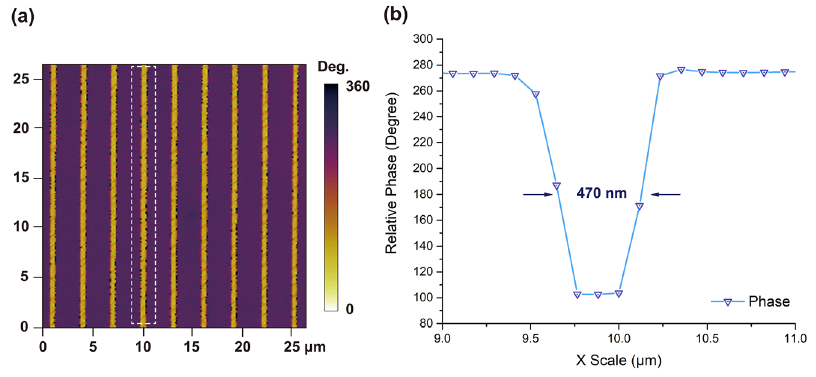
Figure 2: (a) The in-plane phase image after laser-poling. The curve in (b) is averaged across the area indicated by the dotted line in (a), which shows a 180 ° phase difference in the reversed domain. The width of the reversed domain is